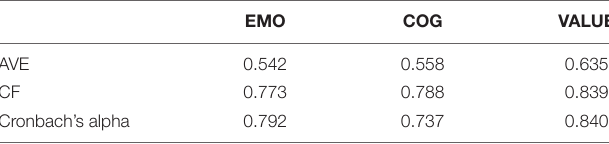
TABLE 4 | AVE, CF, and Cronbach’s alpha for the three subscales of the interest scale. EMO